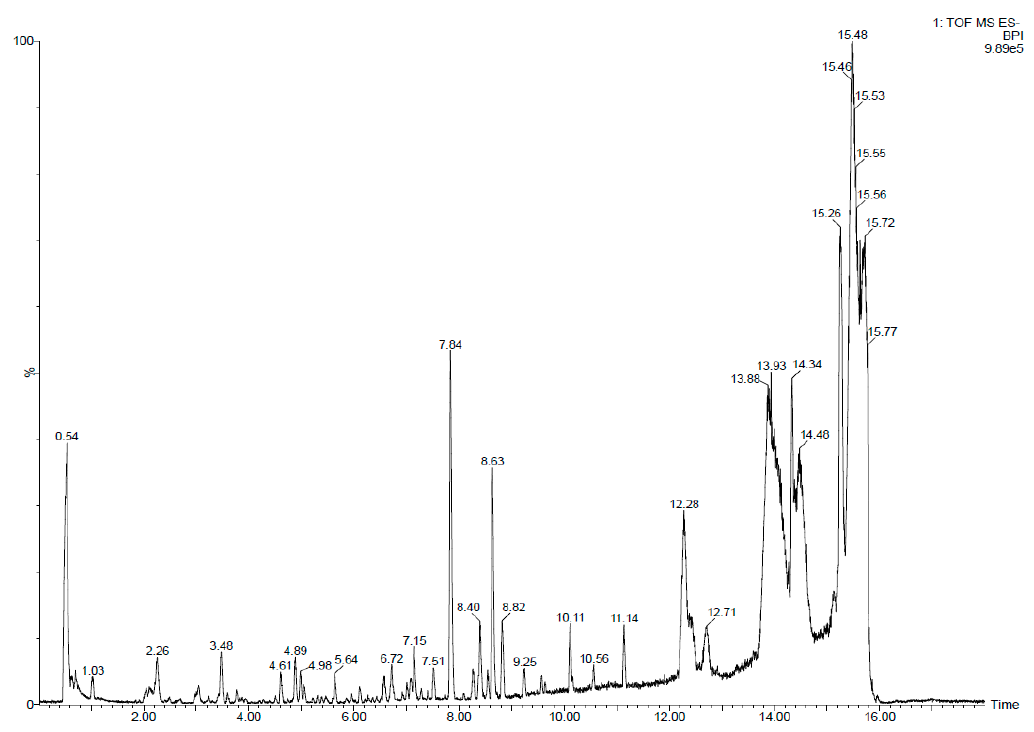
Figure 4. TIC spectrum obtained from Salicornia exudates.